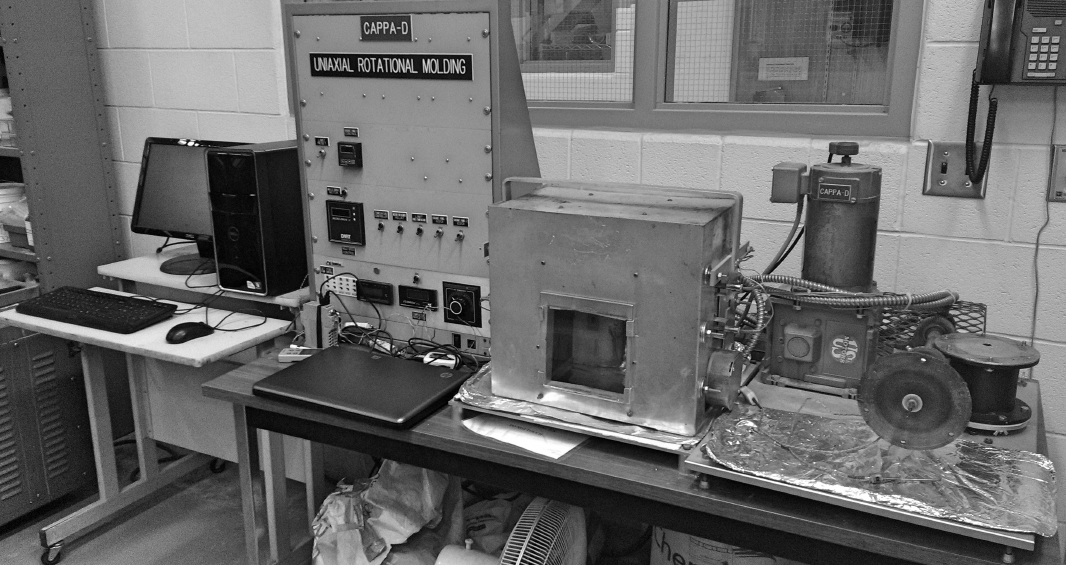
Figure 1. Experimental setup for the rotational molding.